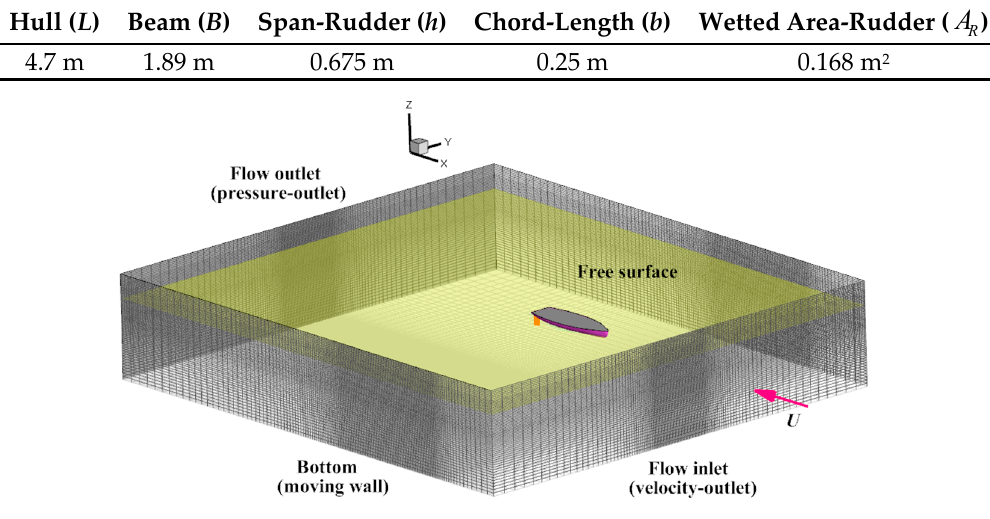
Figure 1. Schematic of the computational mesh and boundary conditions employed in the present simulations.